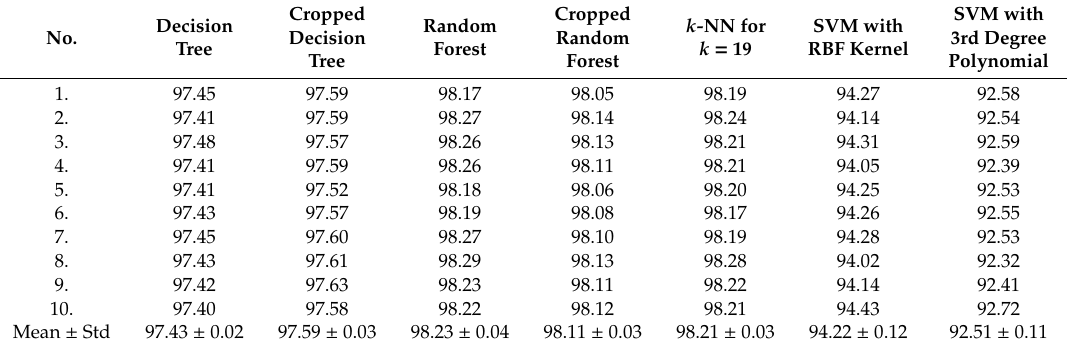
Table 2. Results of 10-fold cross-validation training—classification accuracy for the classifiers trained on the IMU signal samples (training procedure TDR